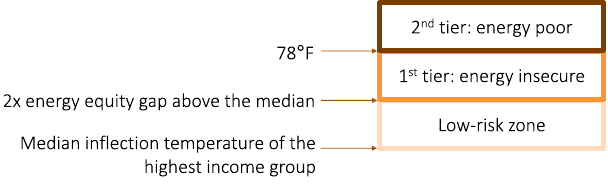
Fig. 6 Tier systems for energy poverty and insecurity identi fi cation using the energy equity gap. The darker the shade the more severe the level of energy poverty experienced by a